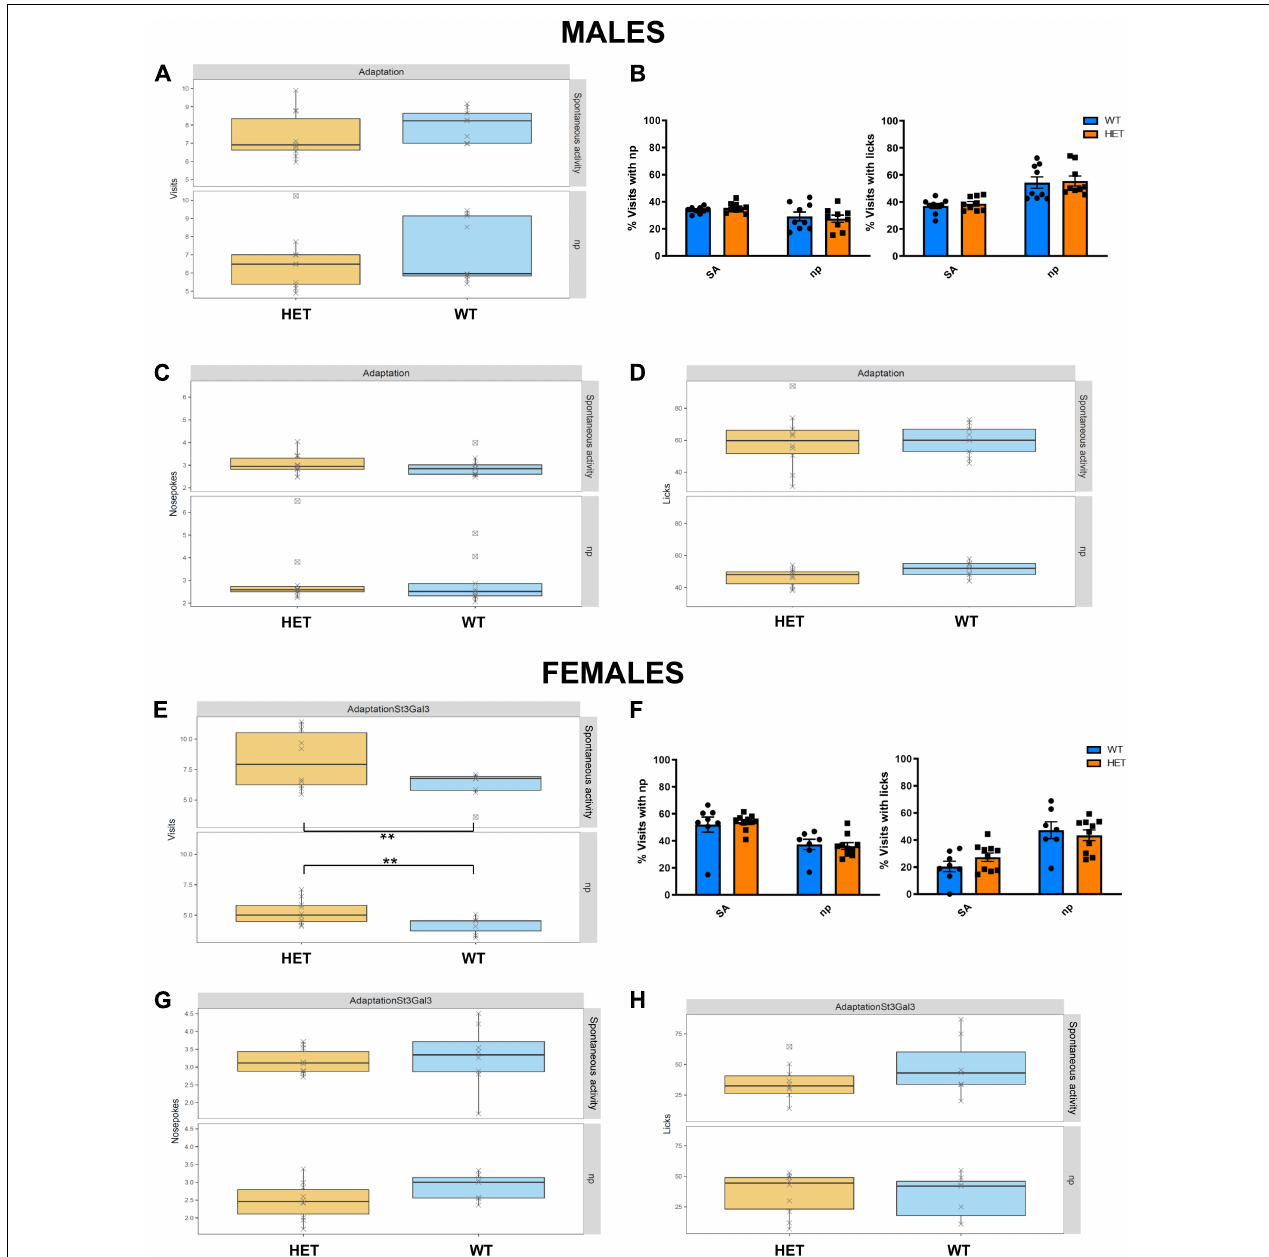
FIGURE 3 | Assessment of exploratory behavior and association between nose-poking and water reward in HET mice. Adaptation phase was divided in spontaneous activity (SA) and nose-poke (Np) subphases, where the following parameters were assessed in the male cohort ( n = 9/genotype) and the female cohort ( n = 8 WT and 10 HET): (A,E) Number of visits/h; (B,F) proportion of visits with nosepokes and visits with licks; (C,G) mean number of nosepokes during visits with nosepokes and without licks; (D,H) median number of licks per visit. No genotype effects were observed in the male dataset. By contrast, female HET animals made significantly more visits compared to their WT littermates ( F 1 , 31 = 9.35, p = 0.0045) Data in panels (B,F) were analyzed by two-way ANOVA. Remaining data were analyzed and plotted with FlowR software. All data are presented as mean ± SEM.